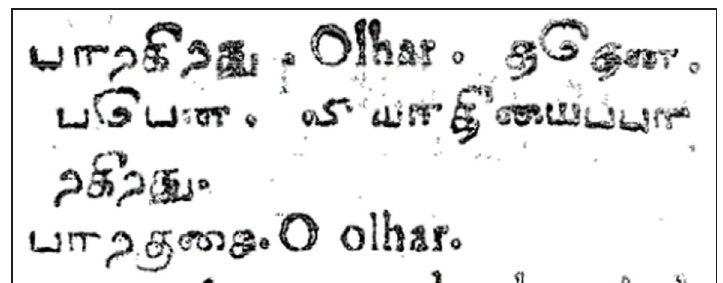
Figure 8: Entries 213_R_a & 213_R_b in the 1679 VTCSP.